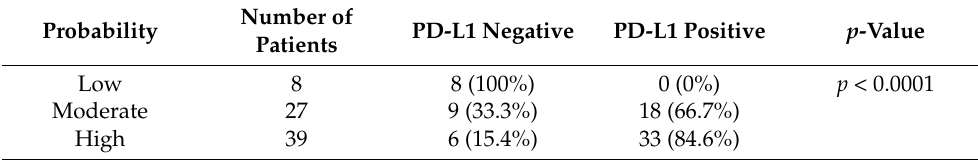
Table 4. PD-L1 expression in the low-, moderate-, and high-potential